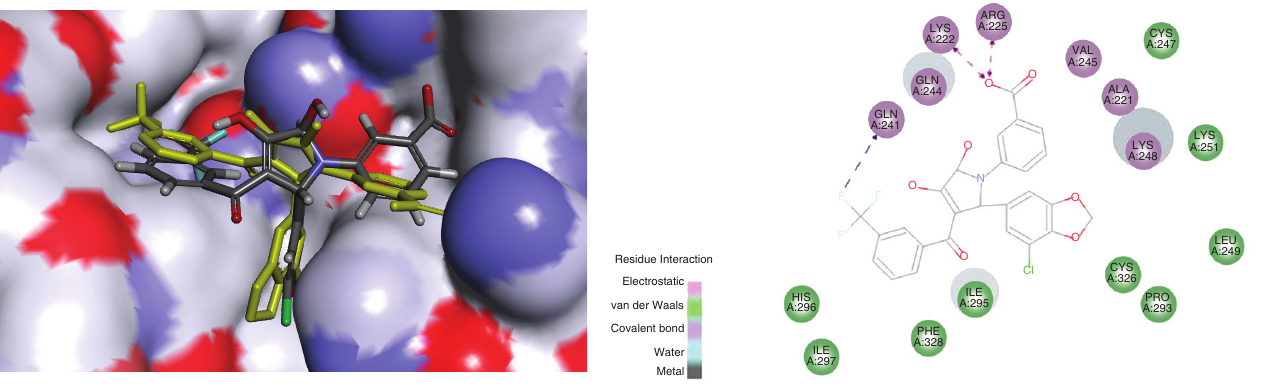
Figure S1. Redocking VPL57 in 4IBI. The 4IBI ligand was removed from the structure and redocked. The closest pose (grey) was ranked 29 with RMSD 3.02A and LibDock score 86.62 when compared to the actual ligand in 4IBI (yellow).